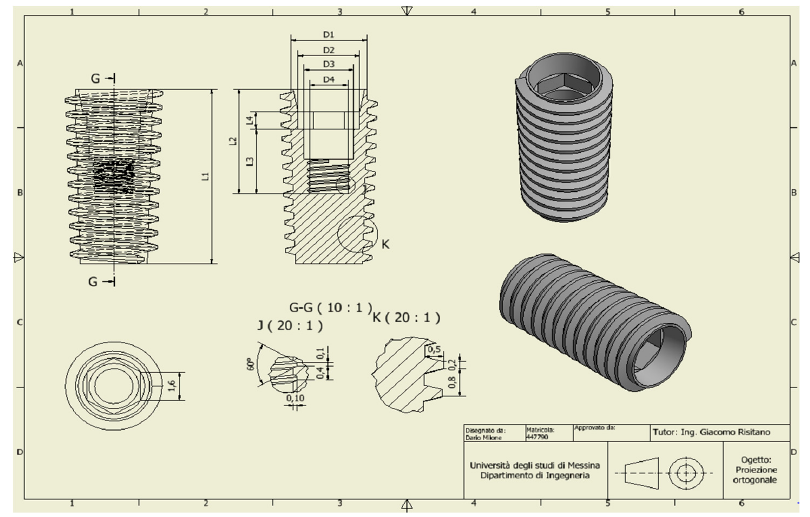
Figure 1. ( a ) Mandible drawing; ( b ) CAD model of the mandible, ( c ) model of cortical and midollar bone tissue areas.